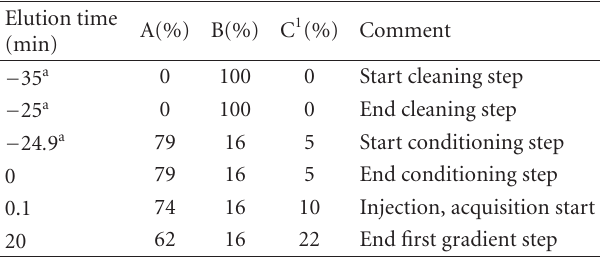
Table 2: Gradient elution program toelute oligosaccharide fraction present in inulin added to cooked